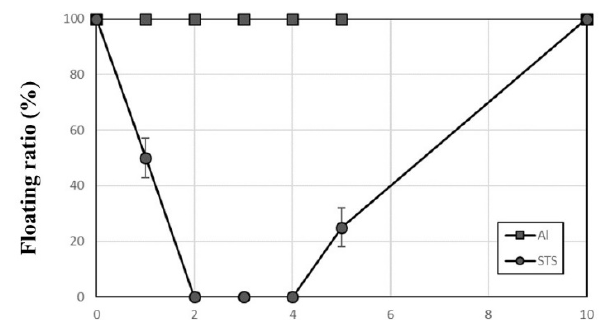
Figure 7. Floating ratio of Al and STS scraps with time during the vibrating test with a vibration amplitude of 3 mm using a mixed ball size medium consisting of a 2:1 ratio of 1-mm and 3-mm zirconia balls.